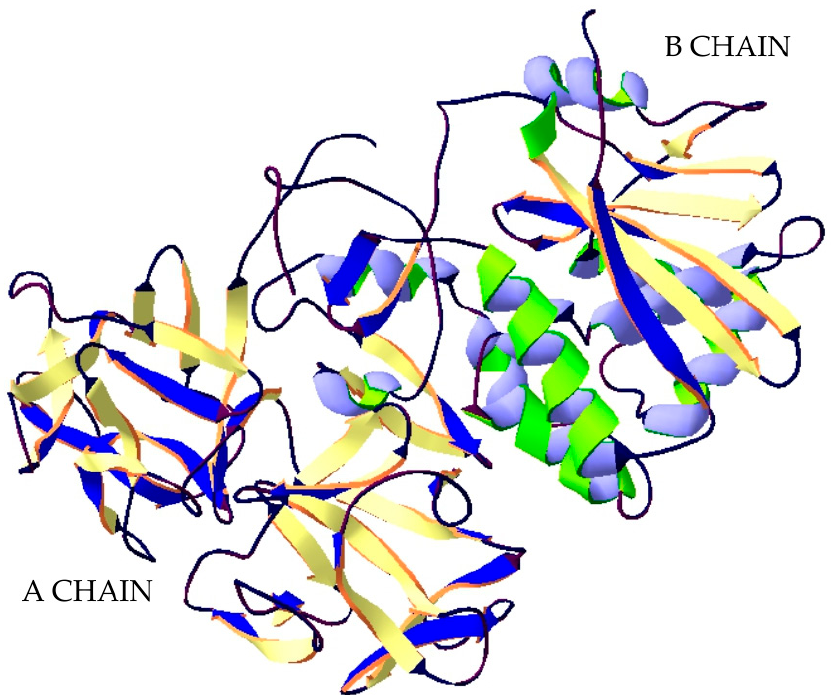
Figure 4. Structure of Ricin. The crystal structure of protein (PDB: 2AAI) [75] was taken from the RCSB PDB databank (http://www.rcsb.org/) (access on 06.03.2018). Visualization of the three-dimensional structure of the protein was performed using the Swiss-PdbViewer (http://spdbv.vital-it.ch/) (access on 05.03.2018). [29].